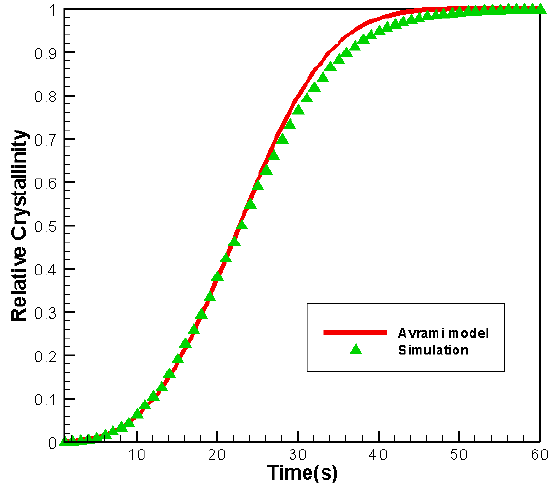
Figure 2. Comparison of simulation result with Avrami model.